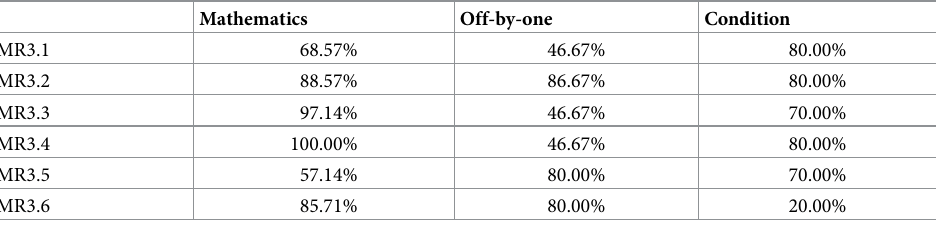
Table 11. Mutation scores of MRs for the deposit cancellation event for different types of